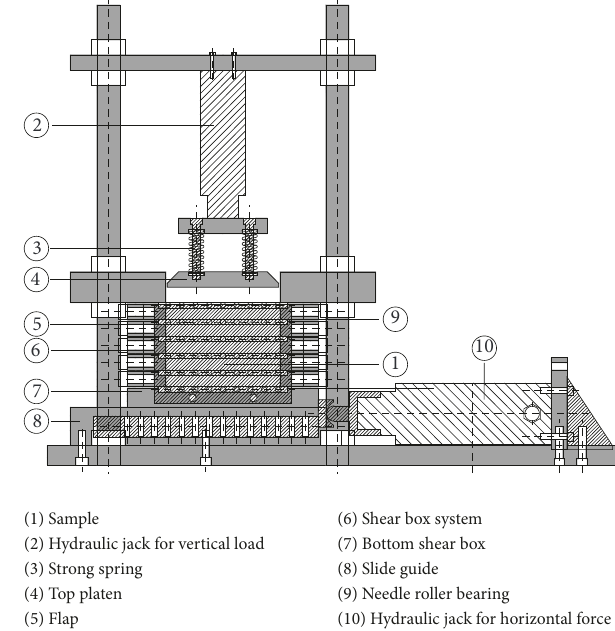
Figure 11: Schematic illustration of the simple shear devices with rotatable plates.